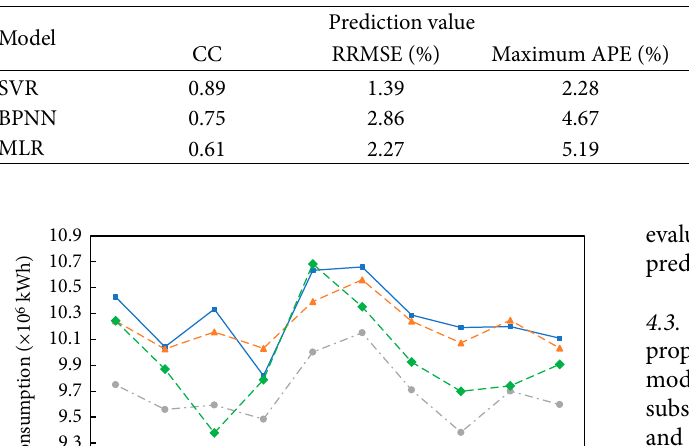
Table 6: Predicted results of SVR model, BP neural model and MLR model.